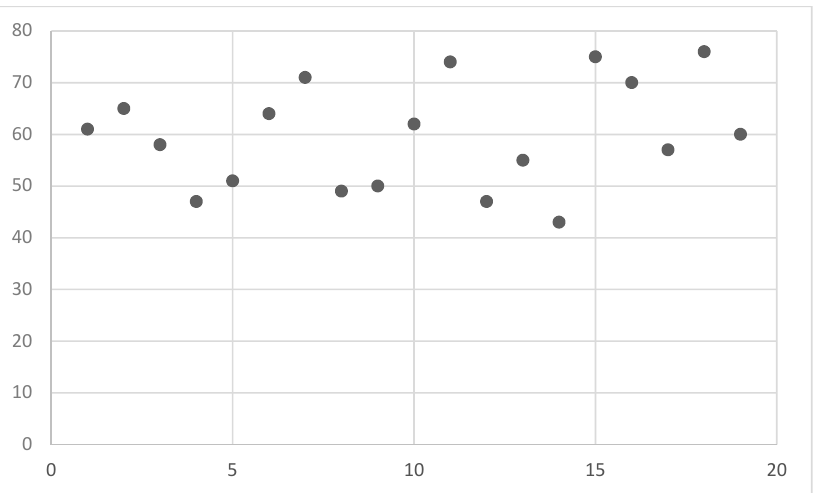
Figure 1. Ratio of women to the total number of employed in tourism in Kazakhstan, %. Source: developed by the authors